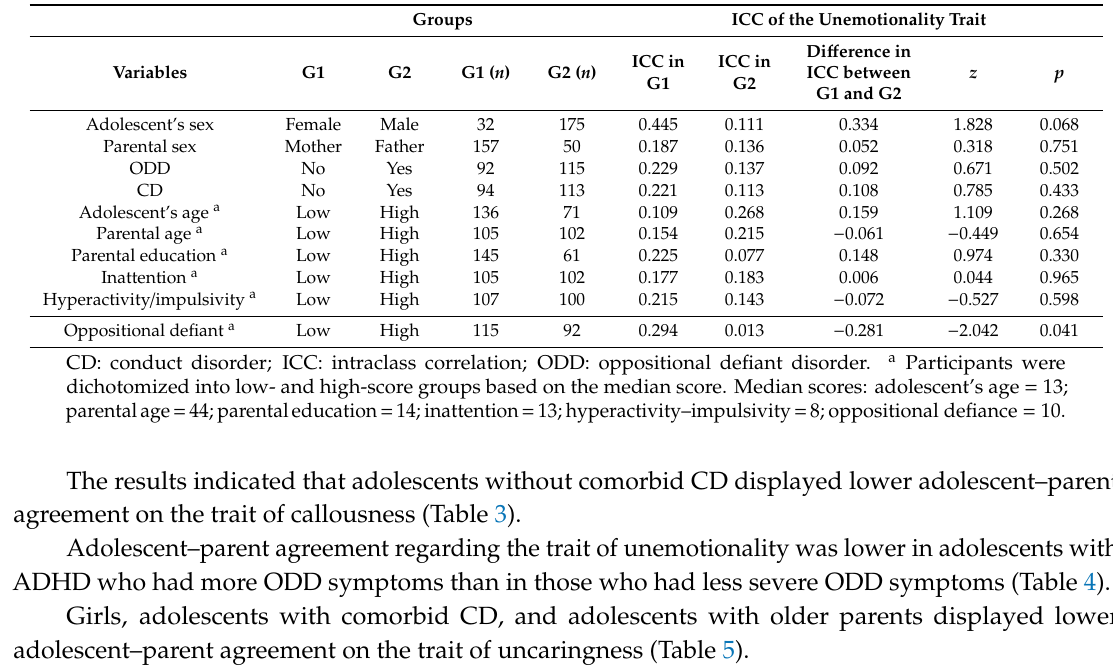
Table 4. Di ff erences in the agreement of adolescent–parent ratings on the unemotionality trait in various groups of adolescents with